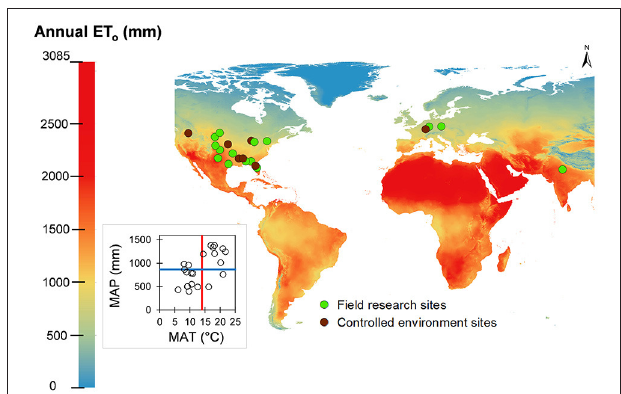
FIGURE 2 | Geographical location and environment (field: green dots; greenhouse: dark red dots) of the 23 studies included in the systematic review, shown over a map of long-term annual grass reference evapotranspiration (ET o ). The inset shows the mean annual precipitation (MAP) and mean annual temperature (MAT) space for the experimental sites. The horizontal blue and vertical red lines represent the average of MAP and MAT across all locations,